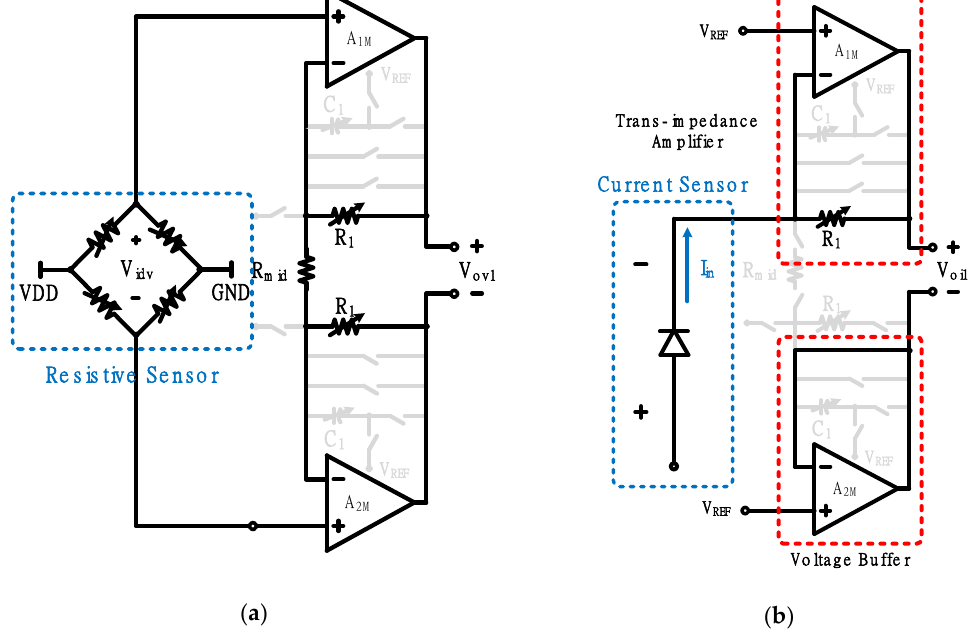
Figure 2. ( a ) Configuration of the voltage / resistive-sensing mode ( b ) Configuration of the current-sensing mode. GND: ground, VDD: dc supply